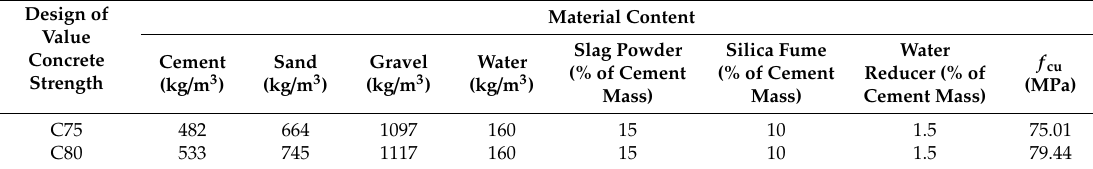
Table 2. Concrete proportions.